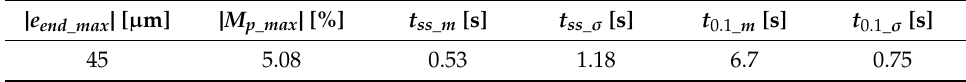
Figure 8. SFC+I controller positioning test results: ( a ) position vs reference; ( b ) error evolution in time; ( c ) detail of ( b ), showing the step where M p_max occurred. Table 3. SFC + I controller performance